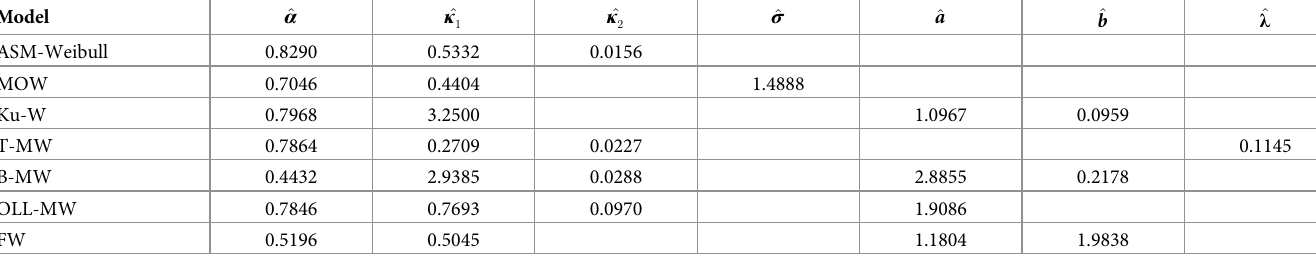
Table 5. Corresponding to the first COVID-19 data, the estimated values of the parameters of the fitted distributions. Model